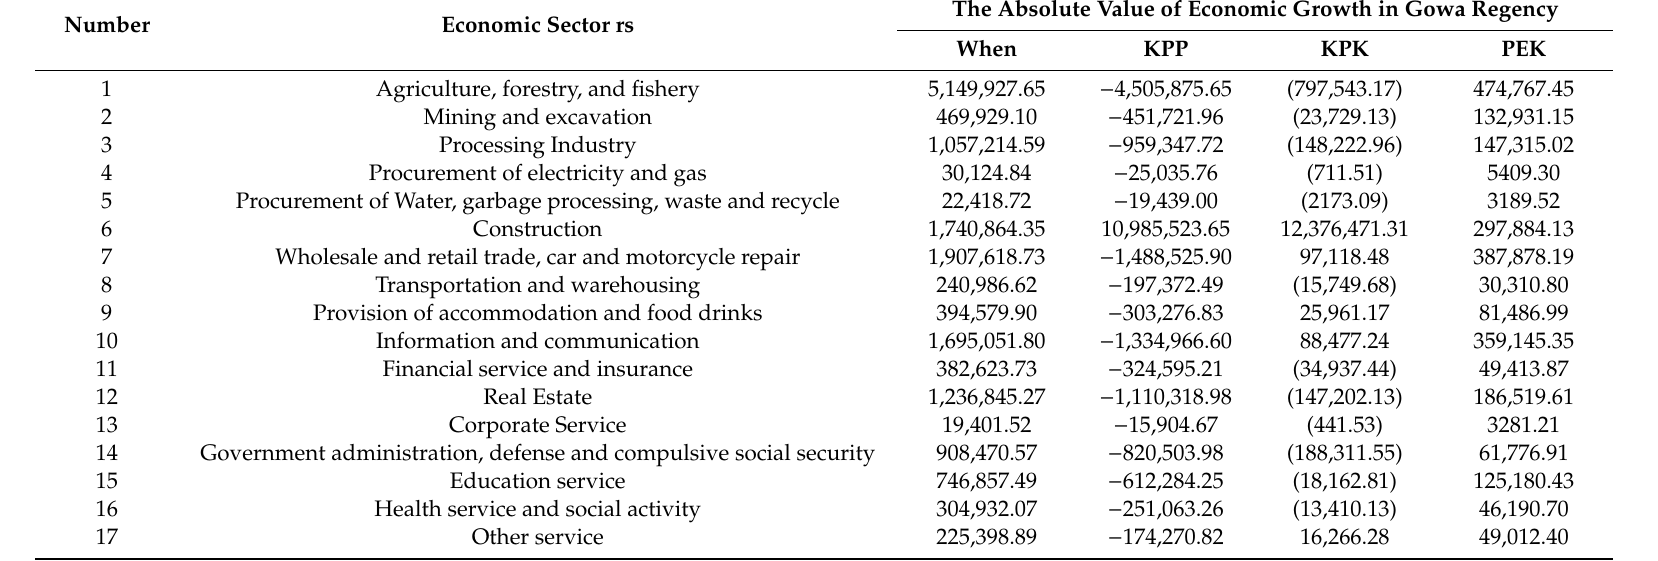
Table A3. Absolute Value of Economic Growth in Gowa